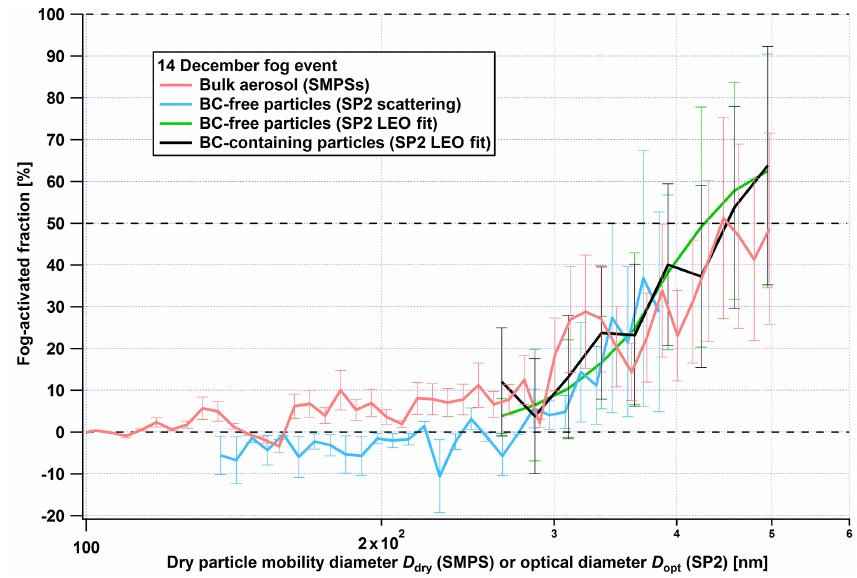
Figure 7. Fog-activated fraction of the bulk aerosol (from total and interstitial SMPS, red line), BC-containing particles (using SP2 LEO fit, black line) and BC-free particles (using SP2 scattering signal: light blue line; SP2 LEO fit: green line) as a function of the dry particle mobility diameter (for SMPS data) and optical diameter (for SP2 data) during the 14 December fog event. The 1 σ uncertainties in the BC- containing particle data are Poisson-based with respect to the BC core number size distribution; the other ones are dominated by the level of (dis-)agreement of the interstitial and total measurements, which was determined during out-of-cloud periods and propagated through the calculation of the fog-activated